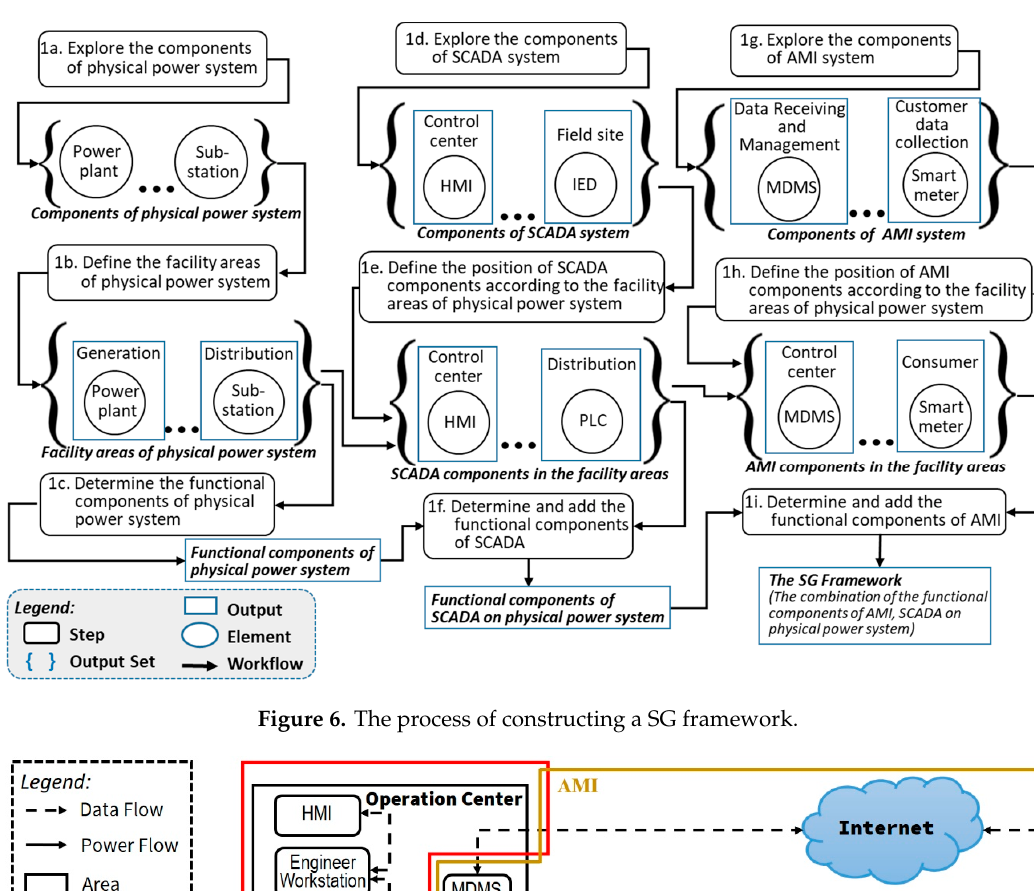
Figure 6. The process of constructing a SG framework.